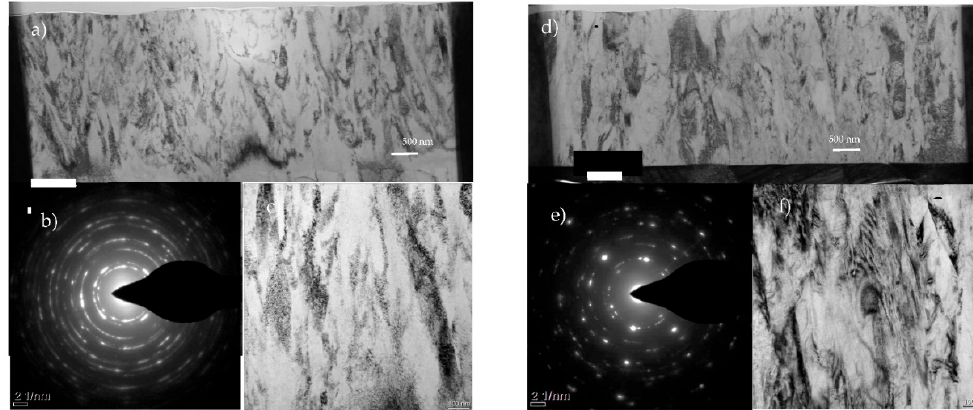
Figure 5. TEM images with SAED diffraction patterns of AlTiN ( a – c ) HiPIMS and ( d – f ) CAD coatings. Micromechanical characteristics of the studied coatings are presented in Table 3. Table 3. Micromechanical characteristics of the studied coatings.